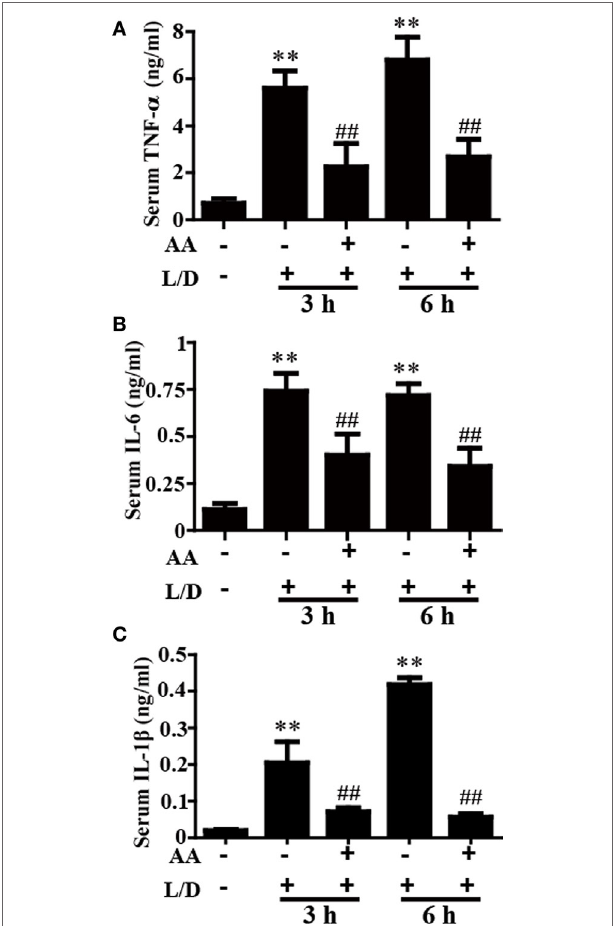
FigUre 2 | Effect of asiatic acid (AA) treatment on inflammatory cytokines in L/D-induced fulminant hepatic failure. AA (25 mg/kg) was administered intraperitoneally to mice 1 h before L/D pretreatment. (a–c) Effects of AA on L/D-induced serum tumor necrosis factor (TNF)- α , interleukin (IL)-6, and IL-1 β generation. Similar results were obtained from three independent experiments. All data are presented as means ± SEM ( n = 5 in each group). * p < 0.05 and ** p < 0.01 vs. control group; # p < 0.05 and ## p < 0.01 vs. L/D